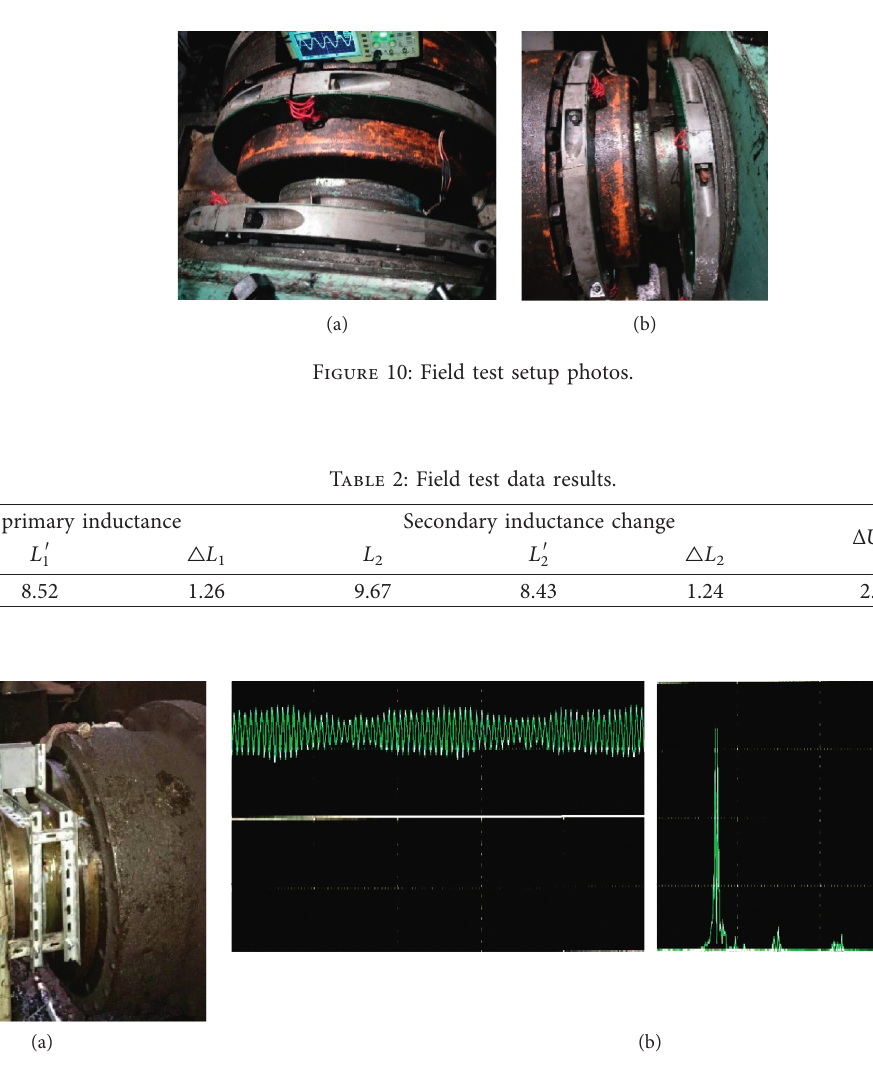
Figure 11: Installed system and torque signal time domain analysis diagrams. (a) Photo of an on-site torque telemetry device. (b) Torque signal waveform and spectrum plots.